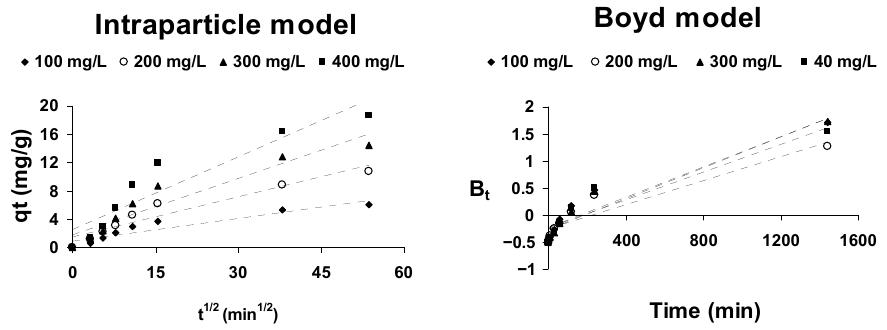
Figure 8. Adsorption mechanism plots for the adsorption of CPC onto AOS.